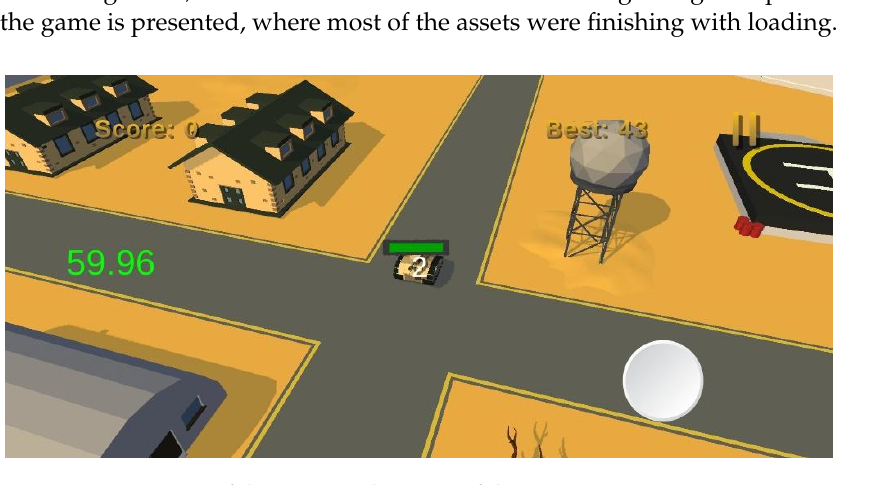
Figure 15. Snapshot after the elimination of 52 enemies in the optimized version of the game. A drop in the value of FPS was recorded after the extermination of 72 enemies, but even in this case it did not fall below the limit of 50 frames, as can be seen in Figure 16.